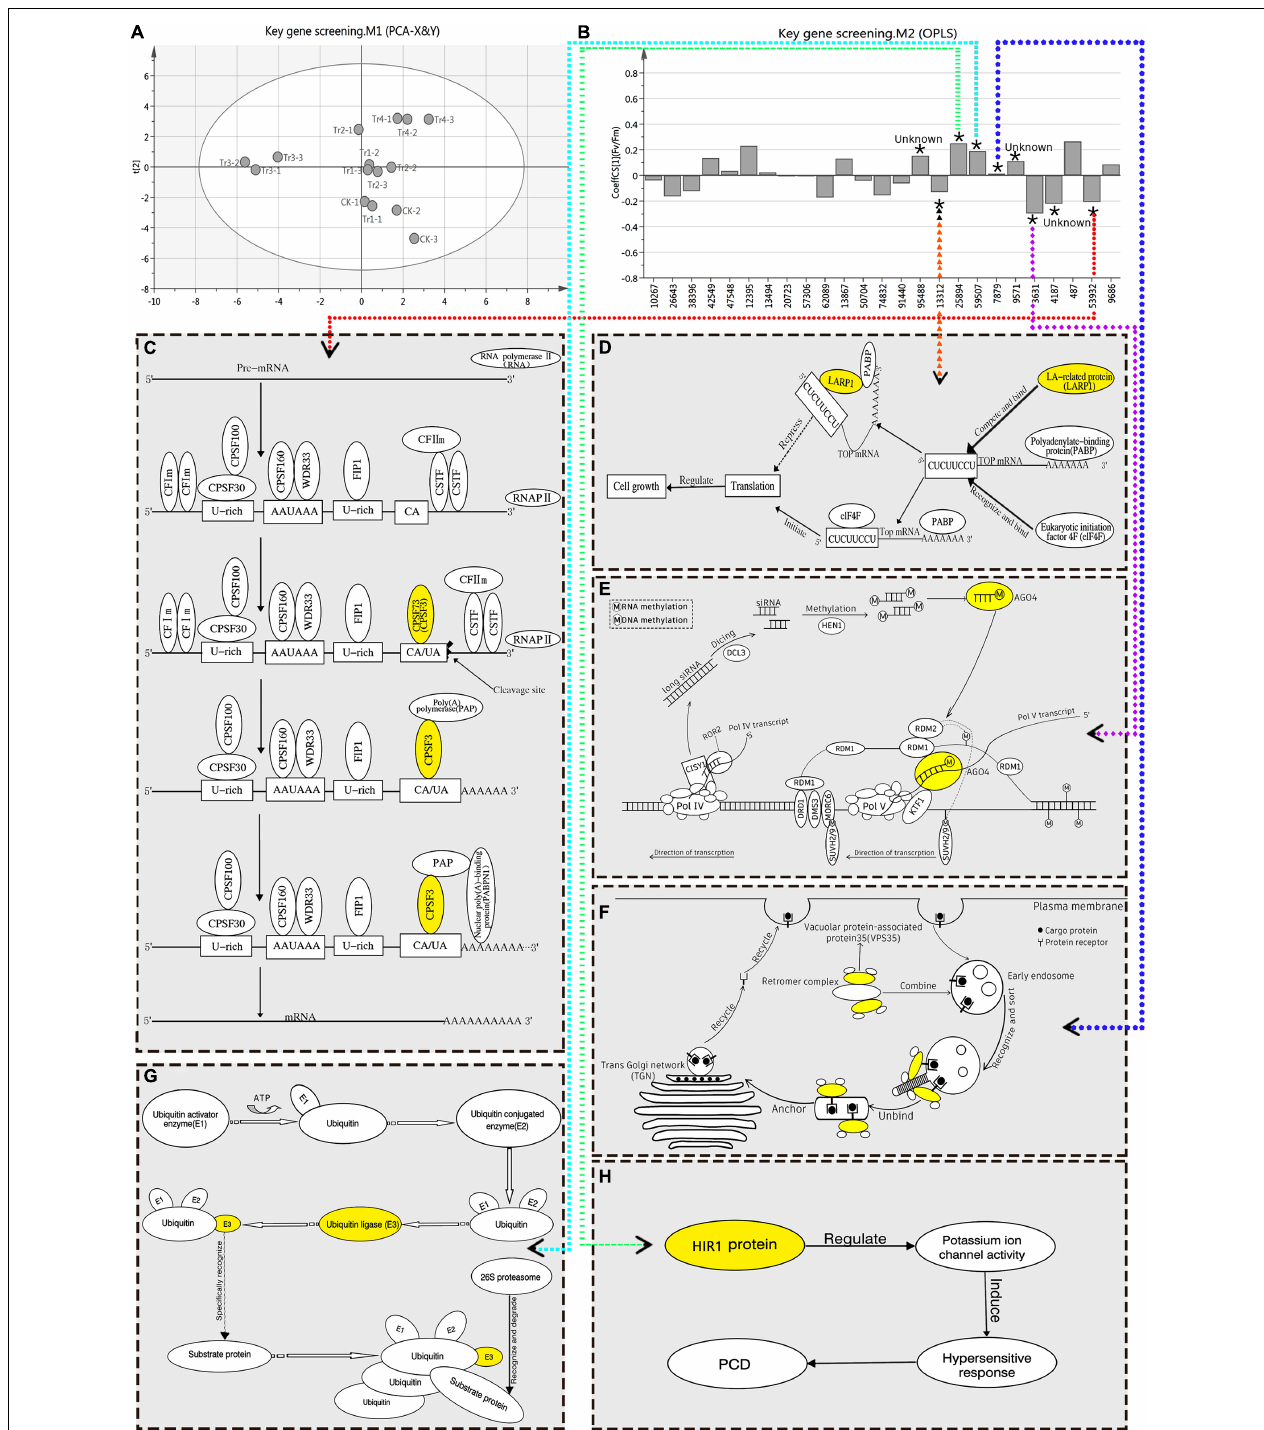
FIGURE 4 | OPLS-RA conduction and filtration of key genes responsive to saline–alkali stress in K. pentacarpos seedlings. (A) Sample score chart of PCA. (B) OPLS-RA model diagram. In this model, “*” indicates that the VIP value of the corresponding transcript is > 1 in this model, “Unknown” indicates that function of the corresponding gene is not clear, the numbers on the x-axis represent transcript ID of 25 core genes, and dotted arrows in different colors point to functional maps of the corresponding genes. (C–H) Function diagrams of the key genes filtered using the OPLS-RA model, including KpCPSF3 ( C , diagram C refers to this literature; Xu et al., 2021), KpLARP1C ( D , diagram D refers to this literature; Philippe et al., 2018), KpAGO4 ( E , diagram E refers to the literatures; Pikaard et al., 2012; Matzke and Mosher, 2014), KpVPS35A ( F , diagram F refers to this literature; Song et al., 2016), KpPUB33 (G) , KpHIR1 (H) .